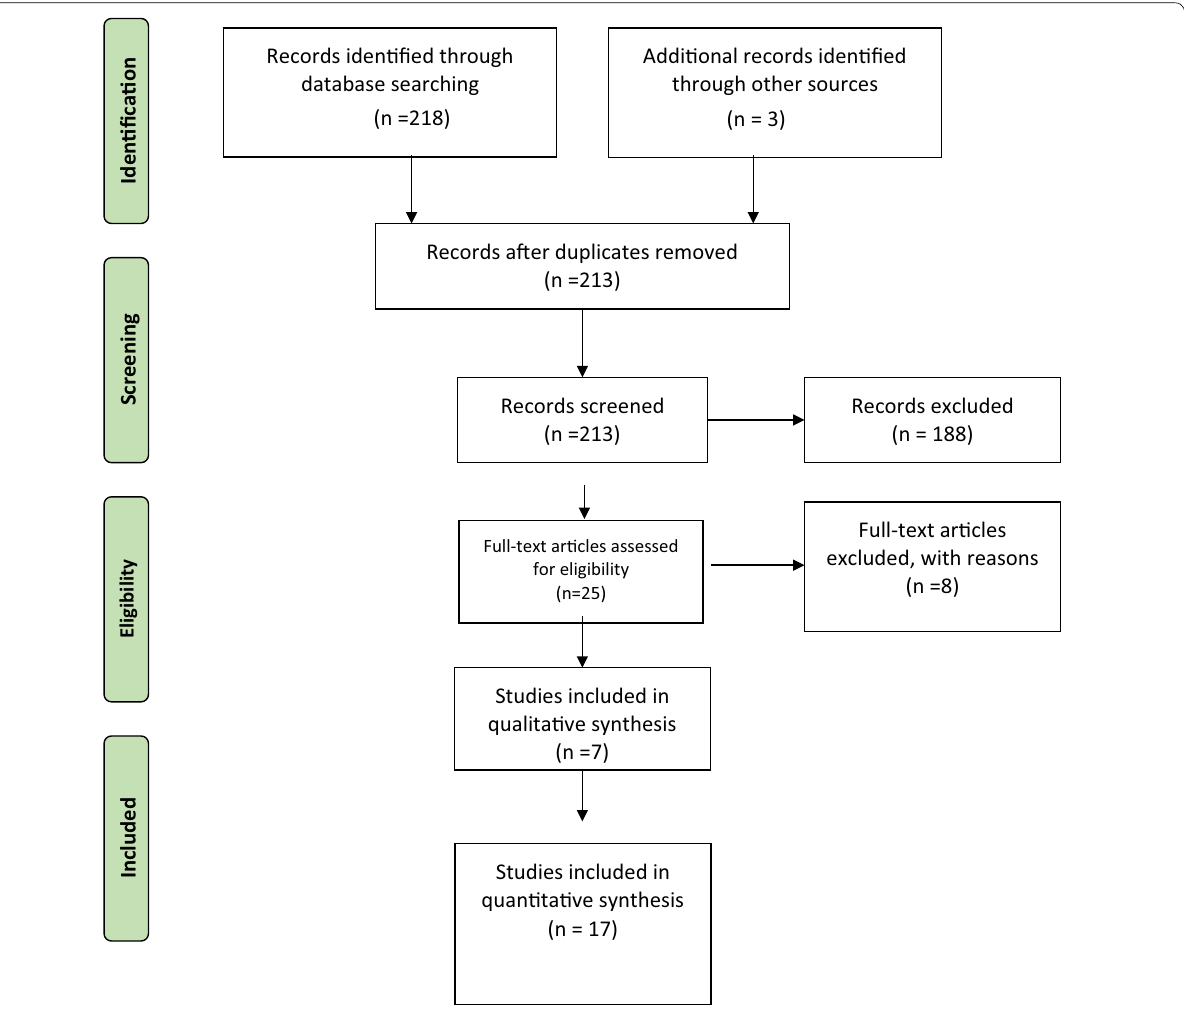
Fig. 1 PRISMA flowchart of literature review and study